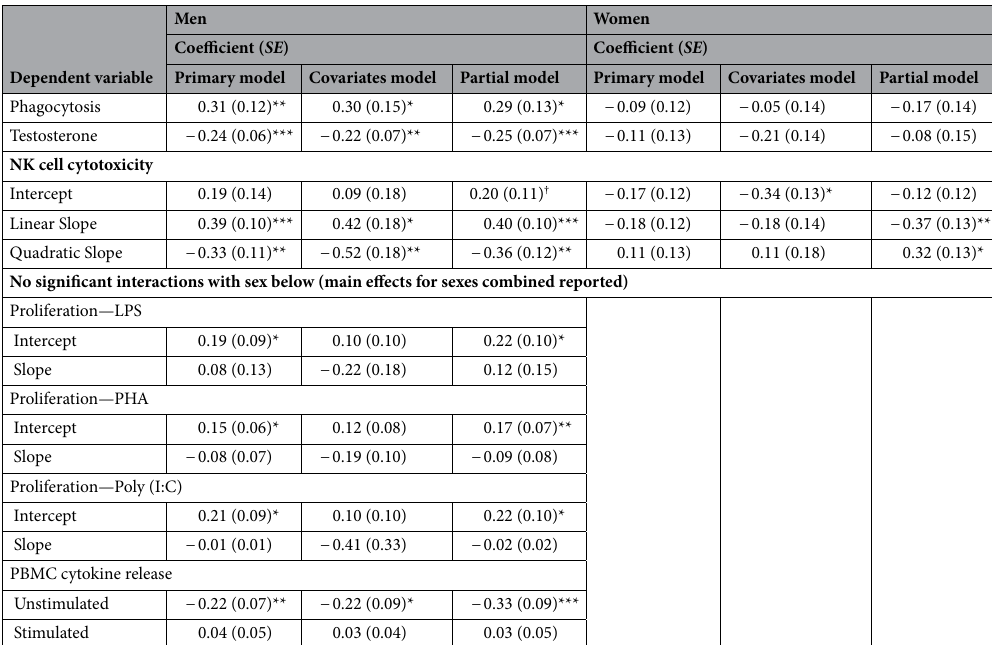
Table 2. Summary of sex-specific simple slopes and main effects of childhood socioeconomic status. Standardized beta coefficients and standard errors ( SE s) shown for main effects (no significant interaction found; bottom panel) and simple slopes within each sex for interactions found between childhood socioeconomic status and sex (top panel). NK natural killer, LPS lipopolysaccharide, PHA phytohaemagglutinin, poly (I:C) polyinosinic:polycytidylic acid, PBMC peripheral blood mononuclear cells. † p < 0.07, * p < 0.05, ** p < 0.01, *** p <